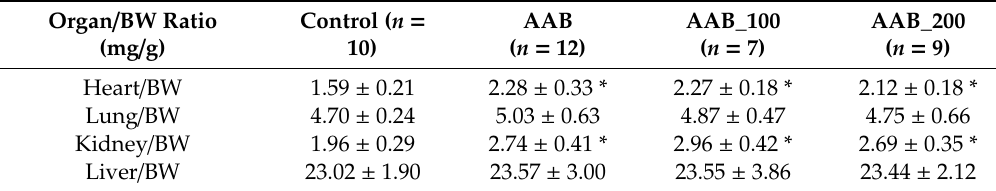
Table 1. Morphometric parameters at 36 weeks